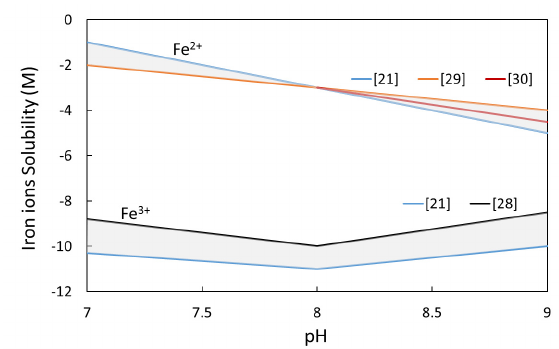
Figure 1. Solubility of Fe 2+ and Fe 3+ species in the pH range of carbonated concrete, according to the indicated literature references, illustrating that Fe 3+ is much less soluble than Fe 2+